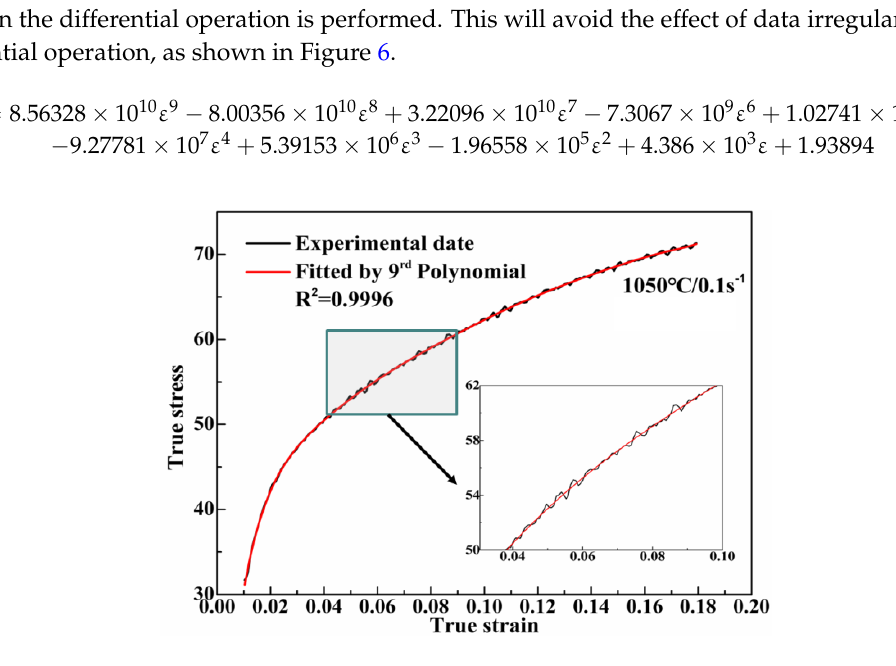
Figure 6. Contrast between experimental curve and fitted curve deformed at temperature of 1050 °C and strain rate of 0.1 s −1 .